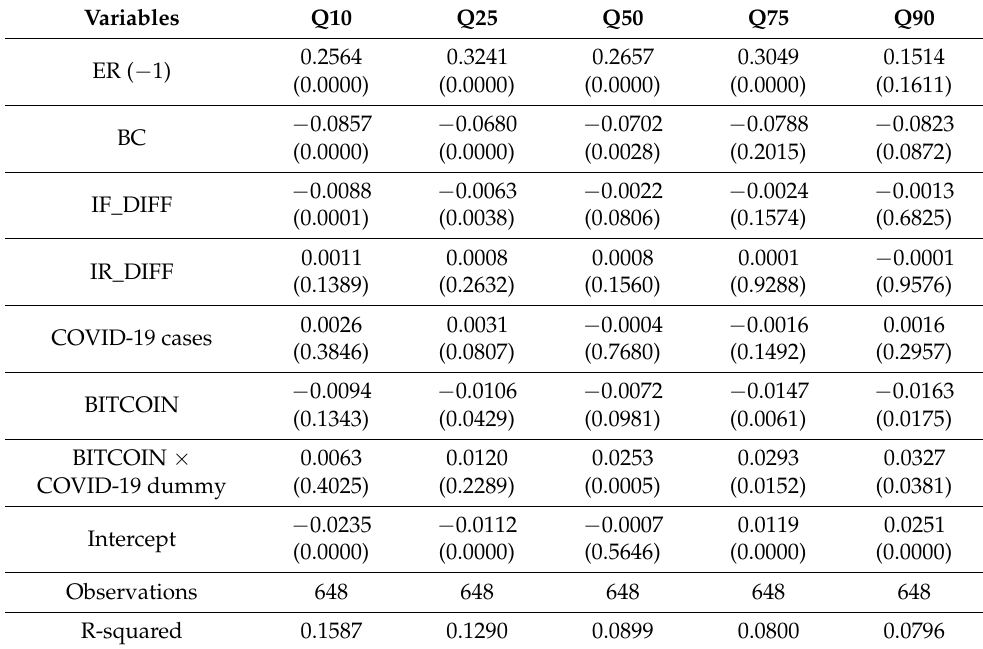
Table 4. UQR estimates ( p -value in